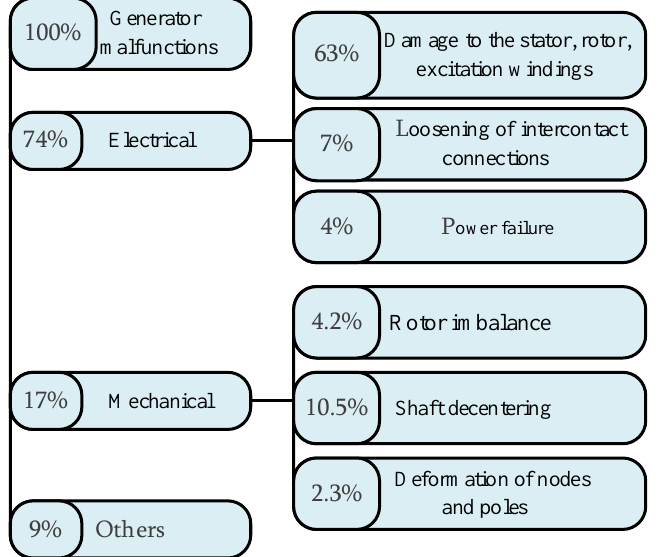
Figure 1. Distribution of the causes of malfunctions or their occurrence in abnormal modes of the generator.